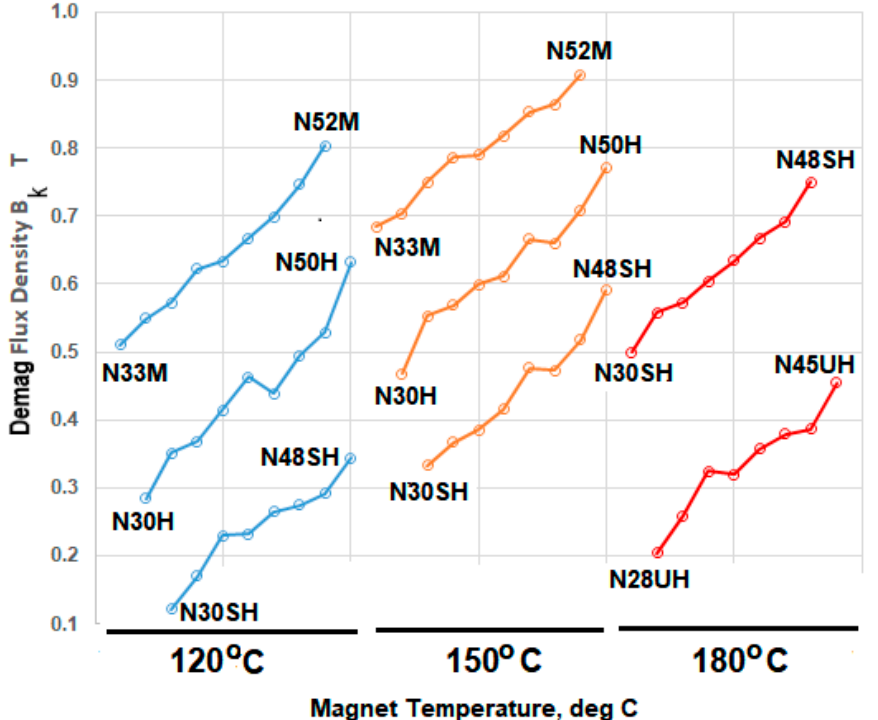
Figure 7. Demag flux density map for all grades over a typical usable temperature range.